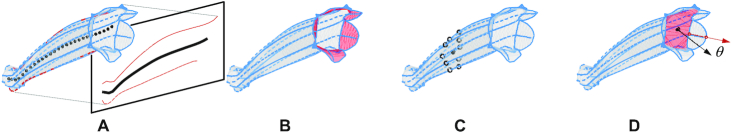
Illustration of corolla shape traits: (A) tube curvature, (B) lobe area ratio, (C) tube dilation, and (D) lobe recurvation. In (A), the dotted line indicates the tube axis, the parallelogram indicates the sagittal plane of the corolla, and the solid line indicates the mapping of the tube axis to the sagittal plane. In (B), the red area indicates the lobe of the corolla. In (C), the hollow dots indicate landmarks on the center tube transection, and the solid dot indicates the centroid of the landmarks. In (D), the red area indicates the tube-opening plane.